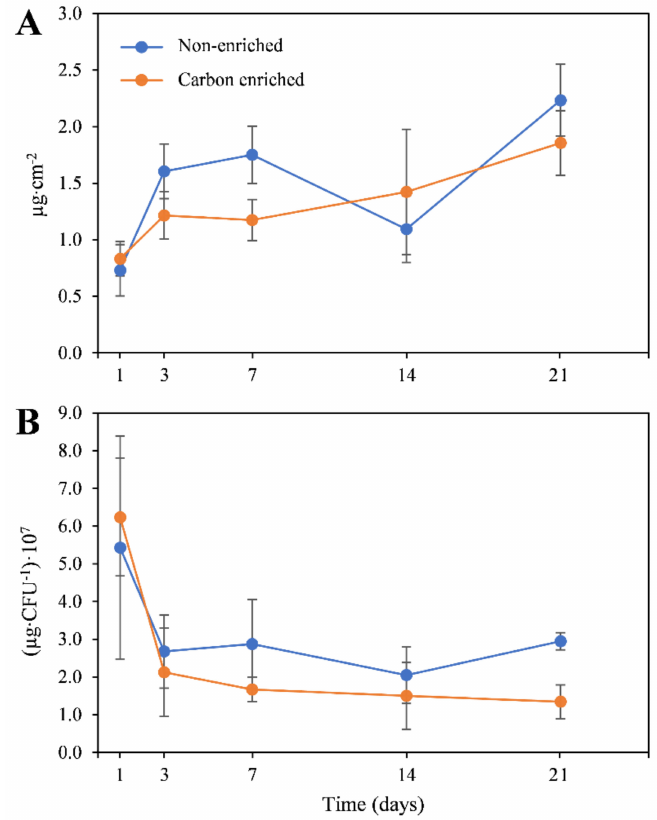
Figure 6. ( A ) EPS (carbohydrate fraction) concentration on granite surface and ( B ) EPS production per cell in biofilms grown in non-enriched medium and in medium enriched with inorganic carbon. Data are expressed as mean values of three independent replicates (error bars indicate standard